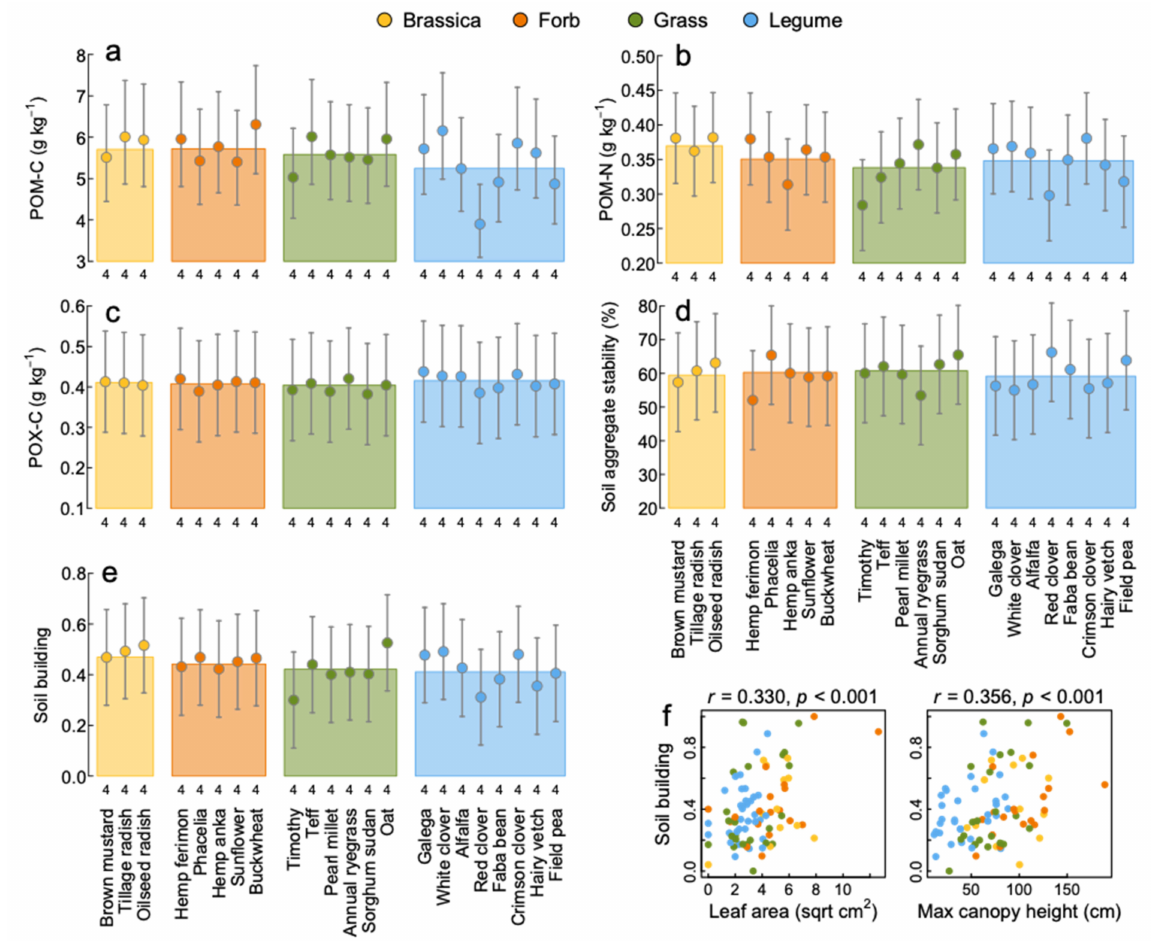
Figure 5. Soil building. Soil particulate organic matter carbon (POM-C) ( a ) and nitrogen (POM-N) ( b ), active carbon (POX-C) and ( c ) the percent soil aggregate stability ( d ) are shown. The scaled average of these are considered as the ecosystem service soil building ( e ). Points show means, and error bars are model estimates of standard errors for comparison among means of the crops. The colored bars show overall means for each plant functional group (indicated by the different colors). Numbers below each mean are the number of replicates used. Statistics are provided in Table 2. Significant correlation (Pearson’s) between soil building and plant functional traits are shown in ( f ). Note soil building was not correlated with leaf mass per area, spring relative growth rate or rooting density ( r = − 0.095, p = 0.392; r = 0.090, p = 0.403; r = − 0.006, and p = 0.958